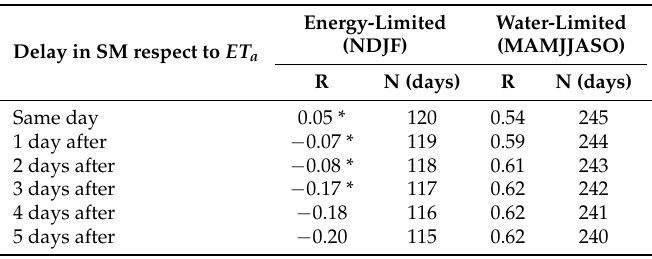
Table 2. Correlation (R) of ET a from HidroMORE and in situ SM from the REMEDHUS network, and number of observations (N) under energy-limited and water-limited conditions along 2014, considering the delayed SM with respect to the ET a day (delay = 0, 1, 2, 3, 4 or 5 days). Energy-Limited Water-Limited (NDJF) (MAMJJASO) Delay in SM respect to ET a R N (days) R N (days) Same day 0.05 * 120 0.54 245 1 day after − 0.07 * 119 0.59 244 2 days after − 0.08 * 118 0.61 243 3 days after − 0.17 * 117 0.62 242 4 days after − 0.18 116 0.62 241 5 days after − 0.20 115 0.62